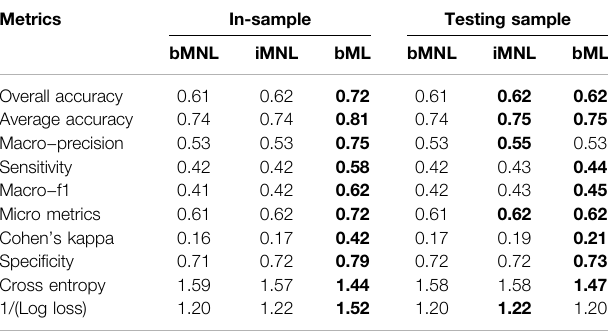
TABLE 3 | Performance metrics for baseline multinomial logit (bMNL), improved multinomiallogit(iMNL),andthebestperformingmachinelearning(bML).Best performing metrics are indicated with bold